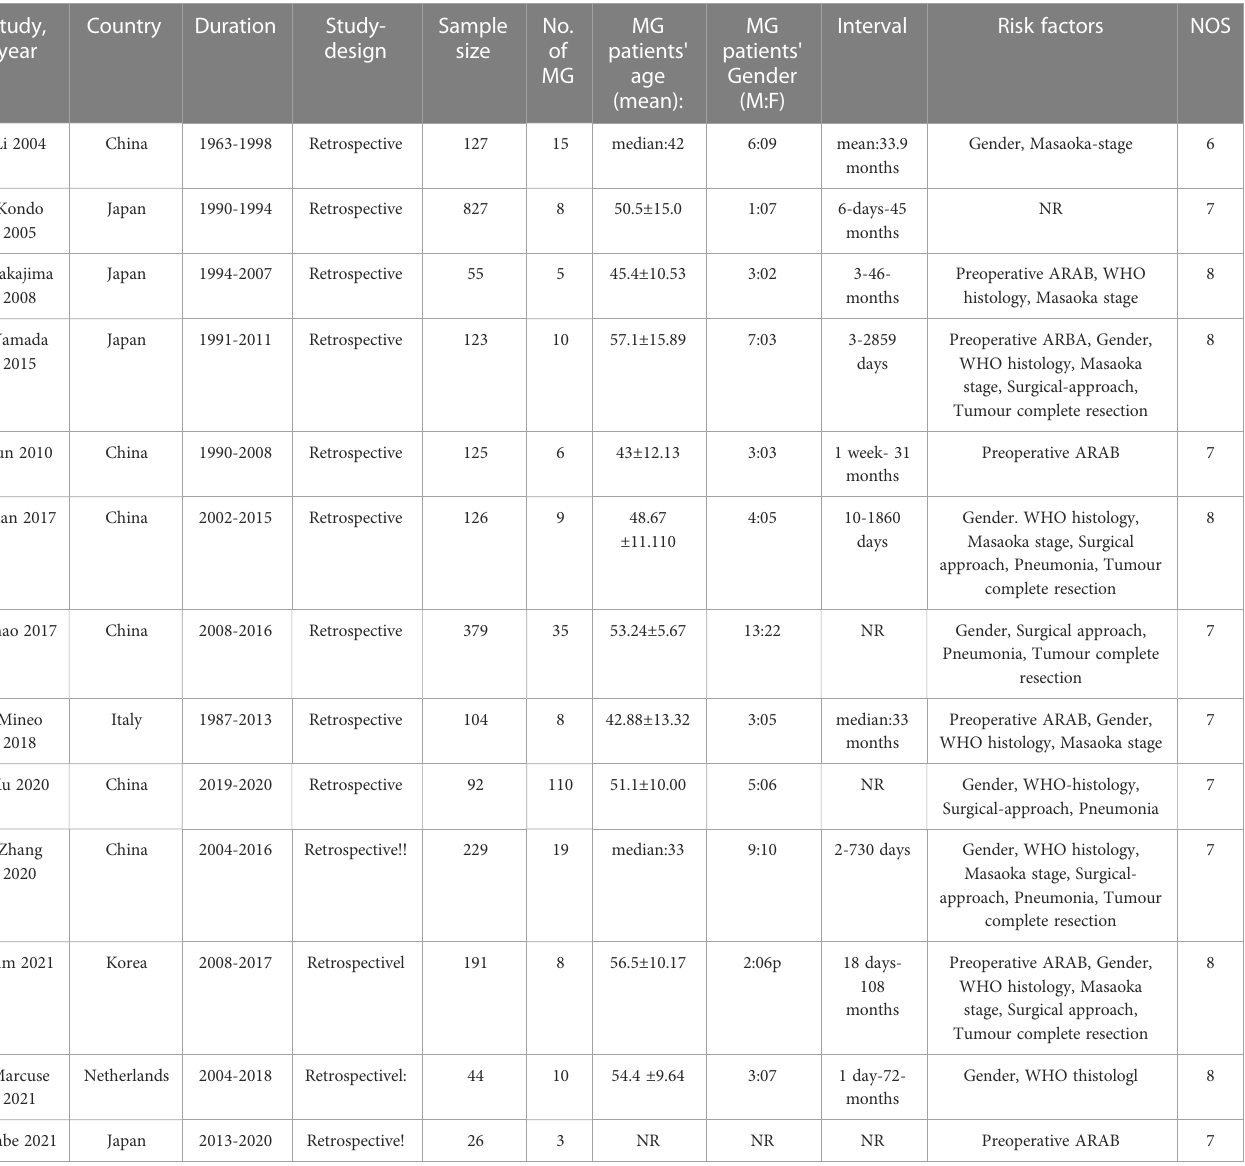
TABLE 1 Characteristics on risk factors for